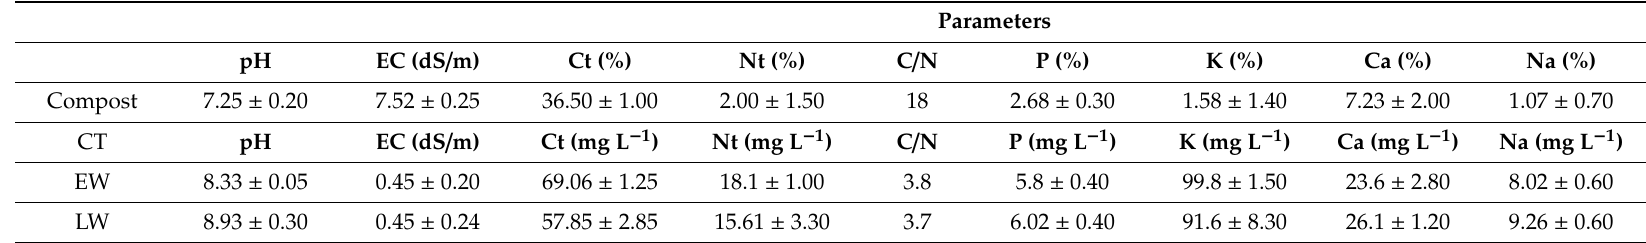
Table 1. Main characteristics of compost and compost tea (CT) used in the experiments (EW: early winter; LW: late winter). Values are the mean ± SD ( n =